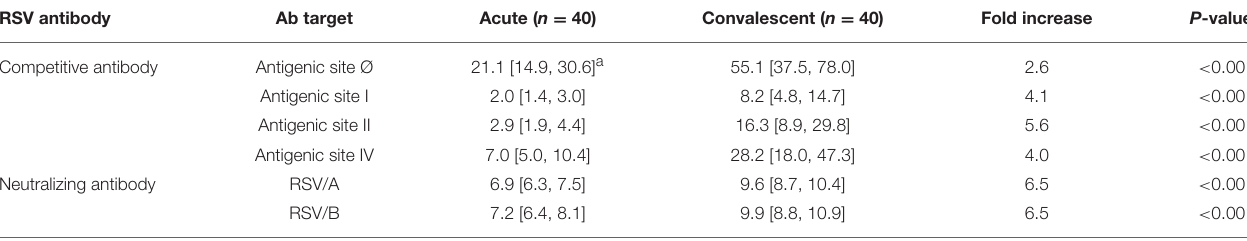
TABLE 1 | RSV Antibody Levels in Acute and Convalescent Sera from RSV infected HCT Adults.